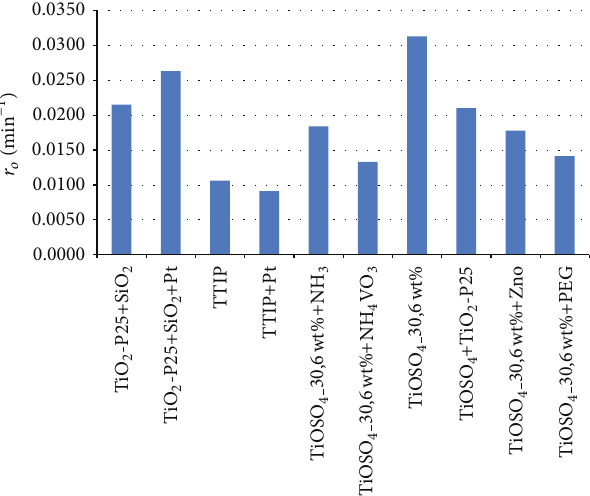
Figure 12: Reaction rates of the photocatalytic degradation of MB (14mg/L) under UV light on immobilized